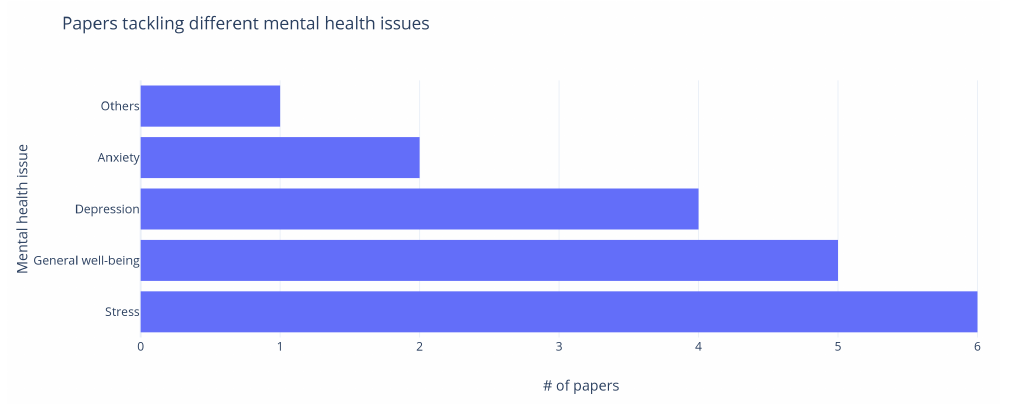
Figure 7. Papers tackling different mental health issues.